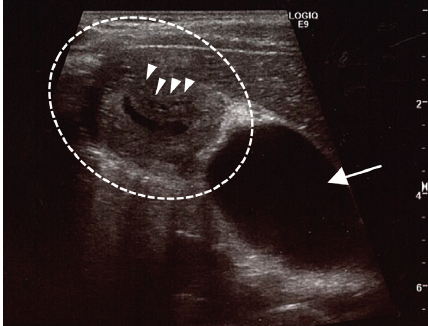
Figure 2: Repeated ultrasonography the next day of admission revealed that the proximal dilated gallbladder (arrow) was con- tinuous with the mass (circle), the wall of which contained several small cysts (arrowheads). Figure 3: Magnetic resonance cholangiopancreatography revealed